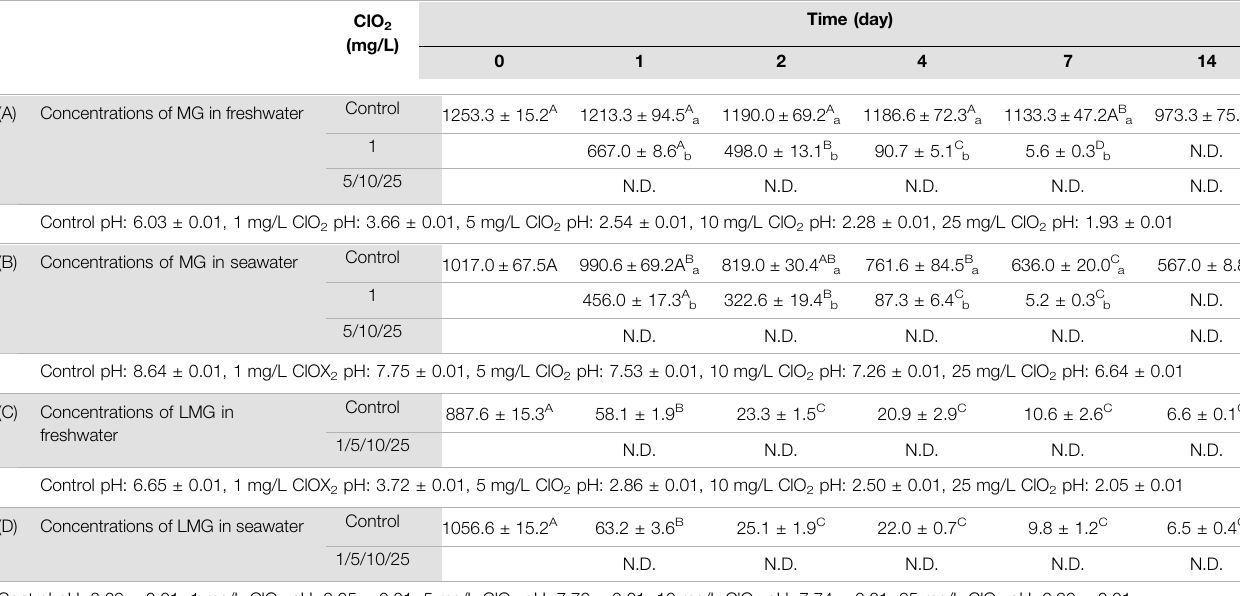
TABLE 9 | Concentrations of MG ( μ g/L) in freshwater after treating with various concentrations of ClO 2 at observation point during 14